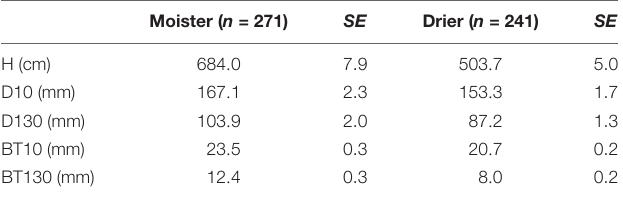
TABLE 2 | Mean values and standard errors (SE) of different growth variables at both test